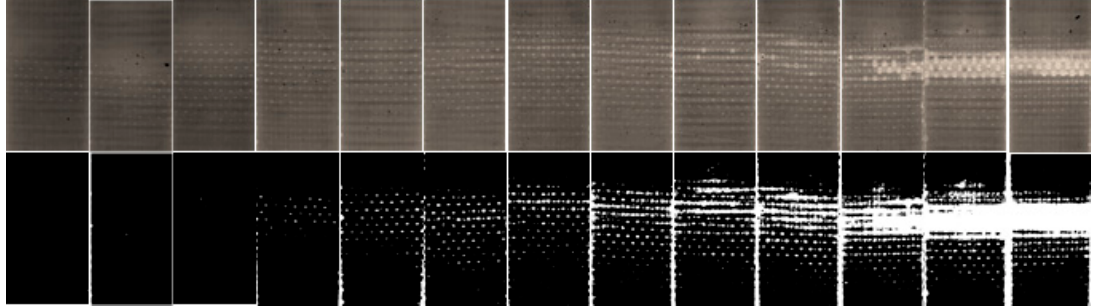
Figure 13. Exemplary set of microphotographs and the results of pre-processing for specimens subjected to self-heating, starting from 40 to 100 °C, with a step of 5 °C. to self-heating, starting from 40 to 100 ◦ C, with a step of 5 ◦ C.